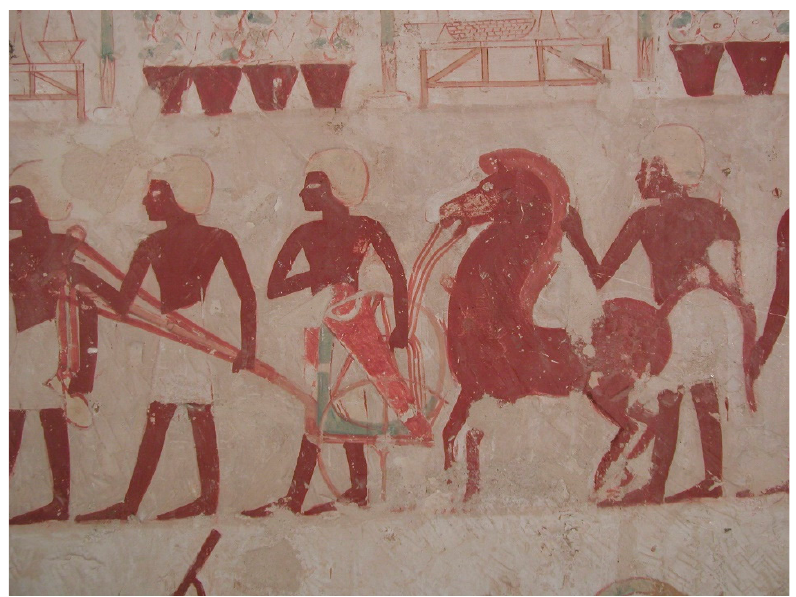
Figure 5. Two horses in the tomb of Userhat (TT56) taking part in his funerary procession. Photo: JJ Shirley.